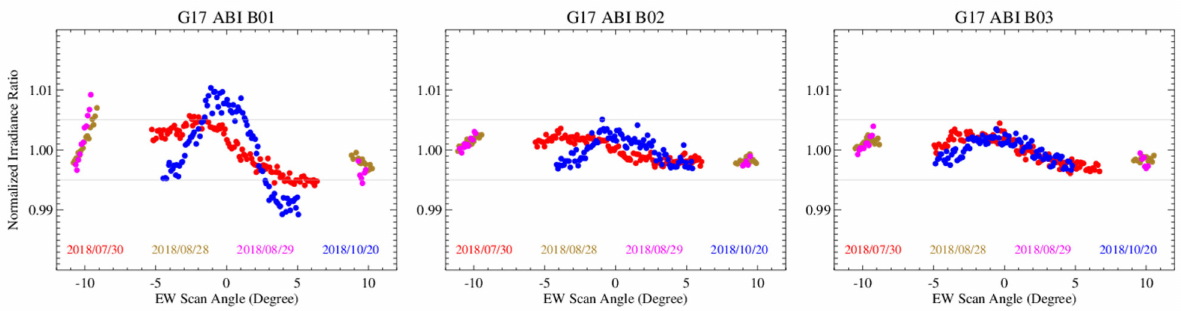
Figure 15. The normalized lunar irradiance ratio versus the scan angle for G17 B01–B03. The spacelook count on 30 July 2018 is corrected with Equation (8). The data on 28 August 2018, 29 August 2018, and 20 October 2018 are corrected with Equation